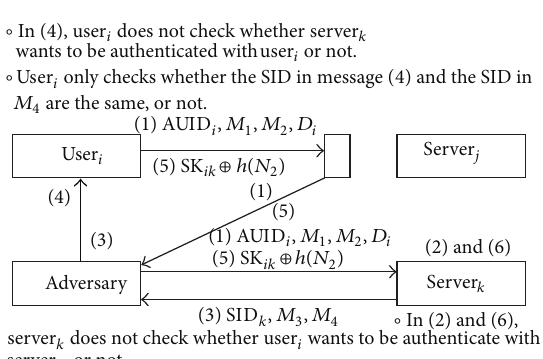
Figure 2: Masquerade attack on Chuang and Chen’s